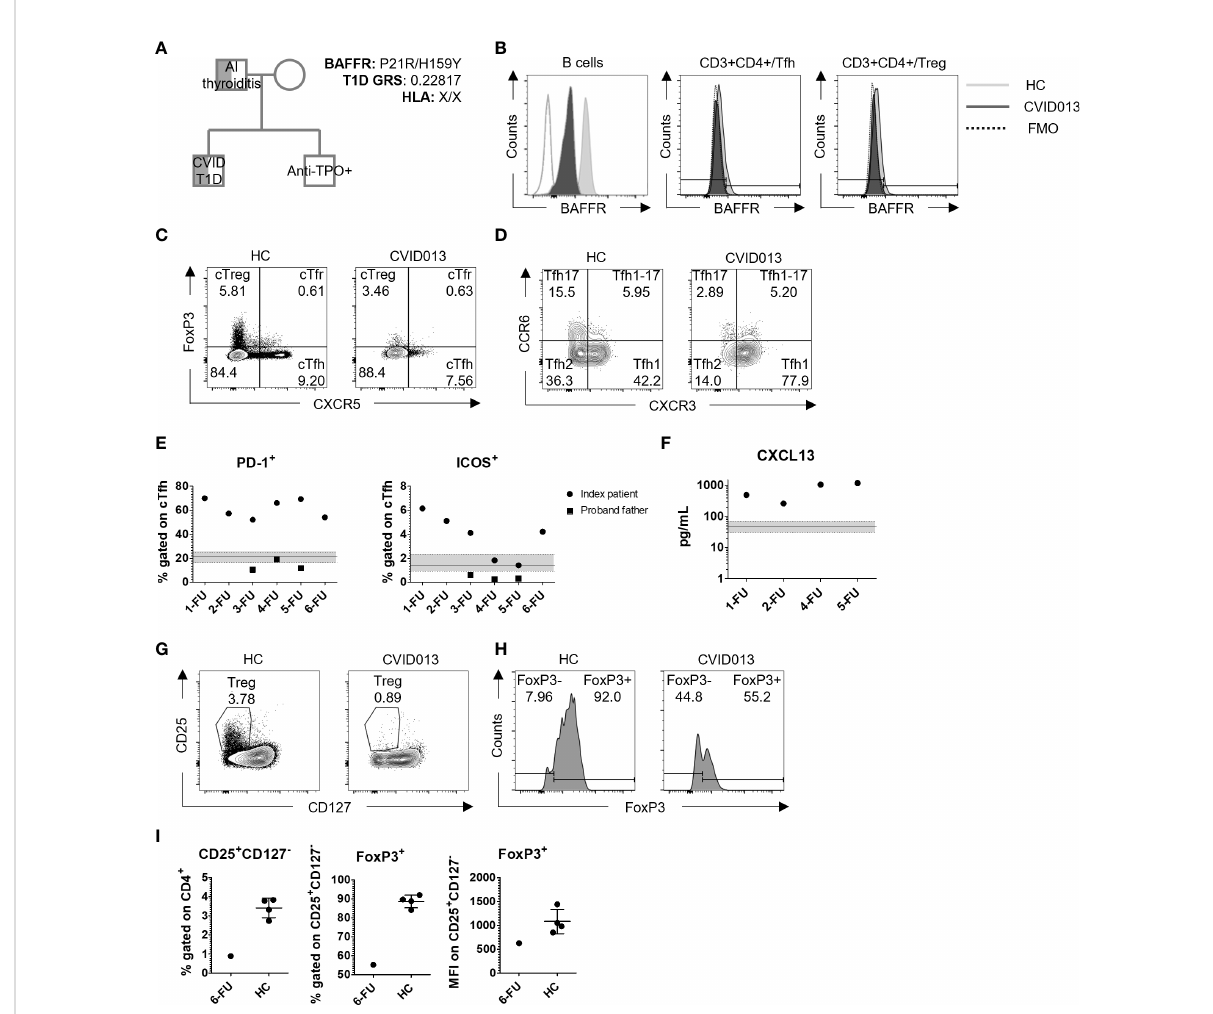
FIGURE 2 Genetic and immunological characteristics of a patient with CVID and stage 2 T1D. (A) Genetic testing identi fi ed low T1D GRS (0.22817, HLA: X/ X), and H159Y mutation in BAFFR inherited in a patrilineal fashion. The father was diagnosed with autoimmune thyroiditis, and the brother was positive for anti-TPO autoantibody production. (B) Representative gating strategy to evaluate BAFFR distribution on B cells, Tfh, and T reg . White, dark, and light gray slopes for control, HC, and CVID013, respectively. (C) FoxP3 and CXCR5 staining on CD3 + CD4 + lymphocytes identi fi es Tfh (CXCR5 + FoxP3 - ), Tfr (CXCR5 + FoxP3 + ), and T reg (CXCR5 - FoxP3 + ) cells, and (D) CXCR3 and CCR6 staining on CD4 + CXCR5 + CD45RA - . The following subsets were identi fi ed: cTfh1 (CXCR3 + CCR6 - ), cTfh2 (CXCR3 - CCR6 - ), and cTfh17 (CXCR3 - CCR6 + ). (E) PD-1 + and ICOS + expressing cells among cTfh are increased over time compared to the HC group (PD-1 + median, IQR = 21.3%, 16.4 – 25.3, n = 65; ICOS + median, IQR = 1.45, 0.91 – 2.32, n = 65). Solid dots and squares represent the index patient and the proband father, respectively. (F) CXCL13 was evaluated in plasma by ELISA assay. Stable higher levels of this chemoattractant were detected over time in CVID patient when compared with the HC (median, IQR = 47.68 pg/ml, 29.52 – 68.24; n = 65), represented by the continuous line within the light gray area. ( G, H ) T reg gating strategy based on CD25 and CD127 expression, and FoxP3 expressing cells among CD25 + CD127 - T reg . (I) CD25 + CD127 - T reg were reduced in the index patient at the fi rst follow-up (HC mean ± SD = 3.42% ± 0.51) and expressed lower levels of FoxP3 (mean HC FoxP3 ± SD = 88.7% ± 3.3; mean HC FoxP3 MFI ± SD = 1080 ±